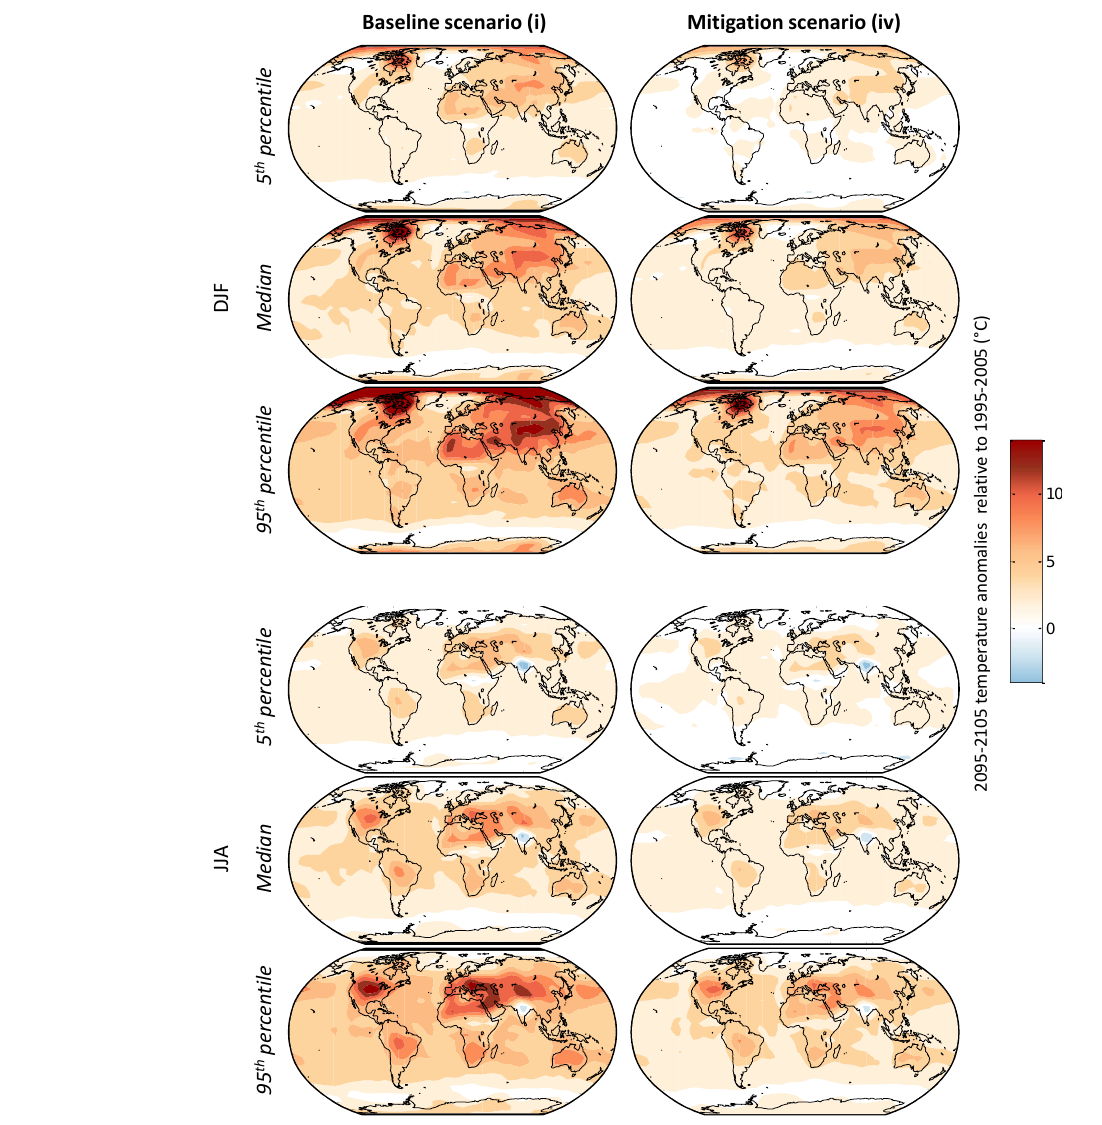
Figure 5. 2095–2105 temperature anomalies relative to 1995–2005 for DJF and JJA under the baseline scenario i (right panels) and the mitigation scenario iv (left panels). The 5th, 50th and 95th percentile of the PLASIM-ENTSem ensemble are calculated independently at each grid point. The PLASIM-ENTSem ensembles are forced with GENIEem median CO 2 concentrations for that